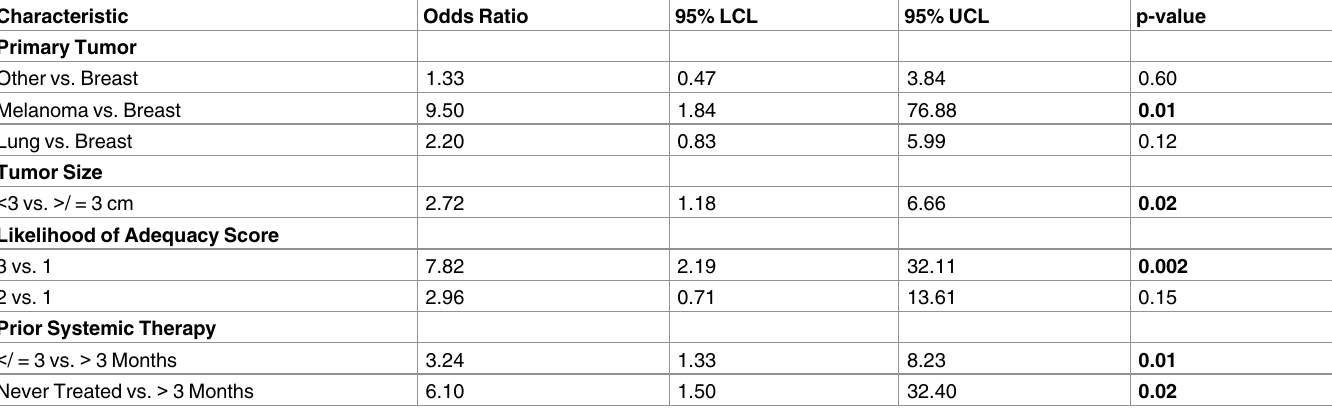
Table 5. Multivariate logistic regression model predicting adequacy for NGS of biopsy specimens.